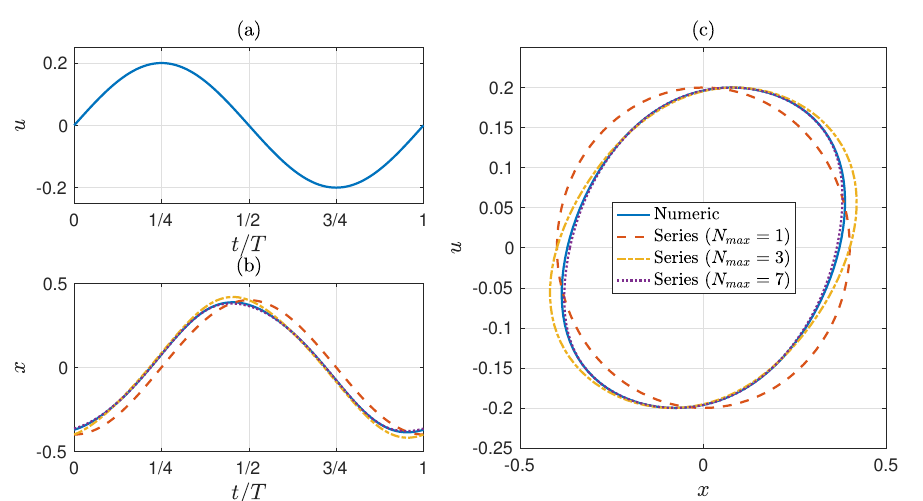
Figure 2. Comparison of system behavior using numeric and analytic solutions (54) for ω = 0.5, A = 0.2 and φ = 0 ( T = 2 π / ω ). ( a ) u vs. t / T , ( b ) x vs. t / T , and ( c ) phase plane ( x , u )